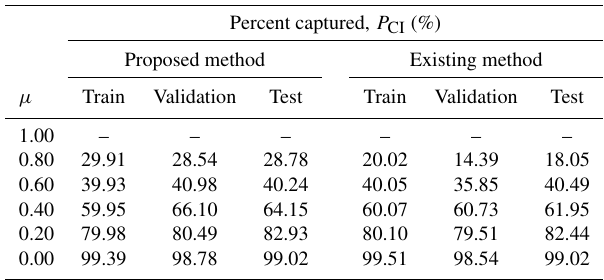
Table 4. Percentage of data captured within each α -cut interval for the three subsets of data.